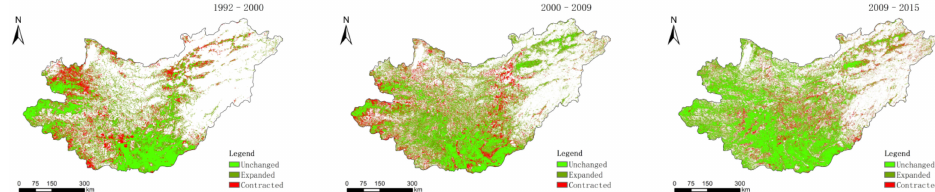
Figure 4. Distribution of grassland changes in 1992–2000, 2000–2009, and 2009–2015.